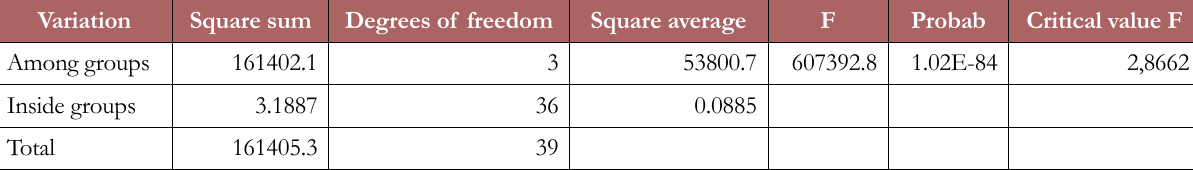
Table 12. Variance analysis. Printed circuit boards